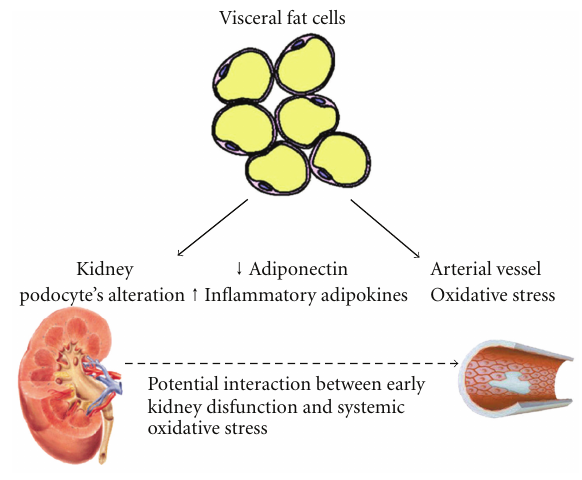
Figure 1: Possible dynamic interactions between obesity, CKD, and CVD. The increase of visceral mass determines both decreased production of ADN and increased production of inflammatory adipokines which result in increased insulin